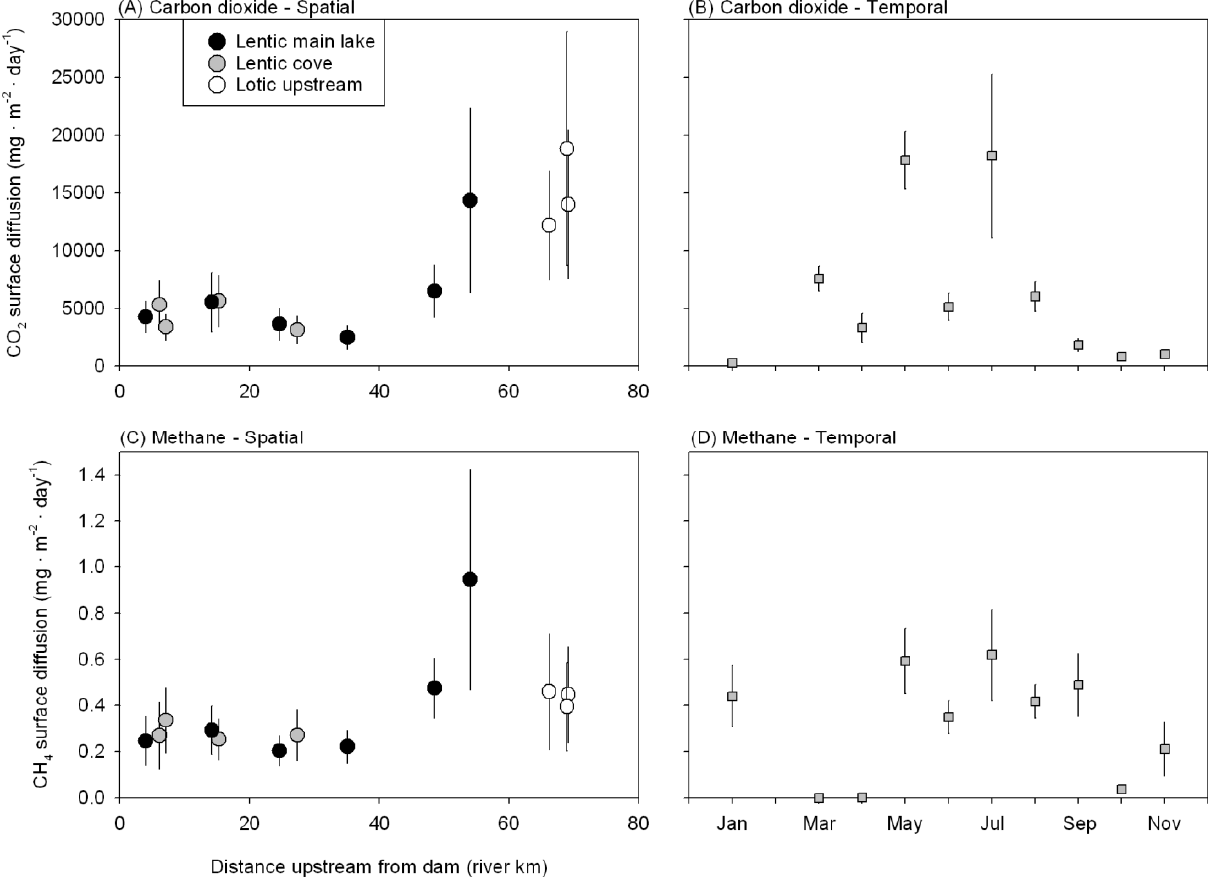
Figure 3. Surface diffusion of ( A , B ) CO 2 and ( C , D ) CH 4 from Douglas Lake as functions of ( A , C ) longitudinal position and ( B , D ) month of the year. Error bars represent 95% confidence intervals around the sample